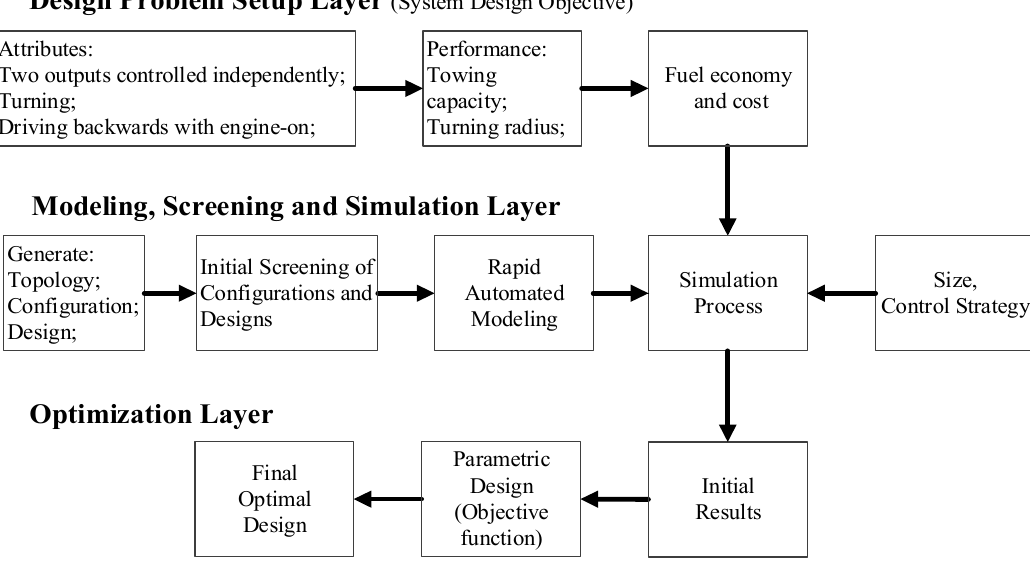
Figure 4. The systematic optimization procedure.